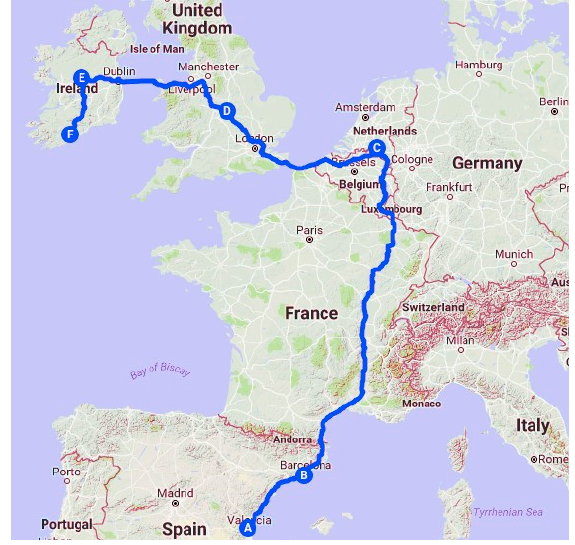
Figure 6. Orange tracking.